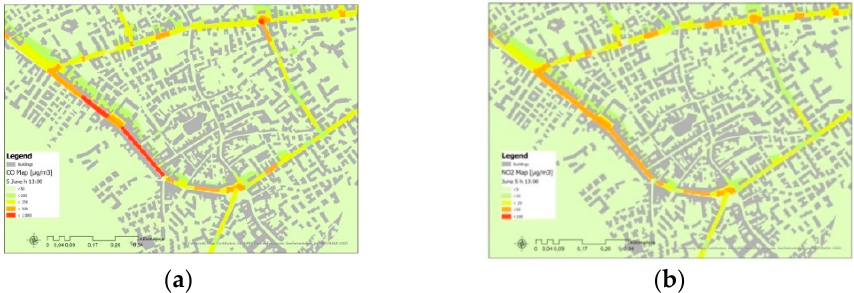
Figure A2. Maps of the estimated concentrations on 5 June at 1 a.m.: ( a ) CO concentrations; ( b ) NO 2 concentrations.